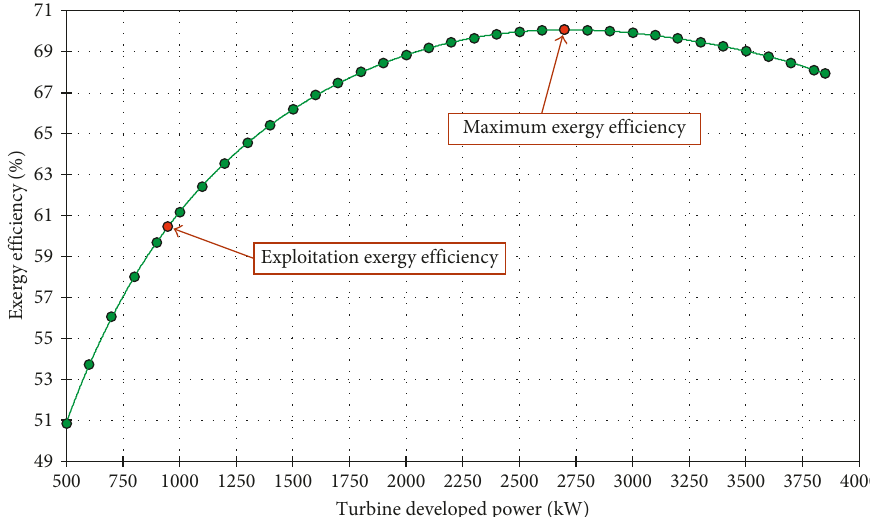
Turbine developed power (kW) Figure 9: Steam turbine exergy efficiency change during the developed power variation—operating point